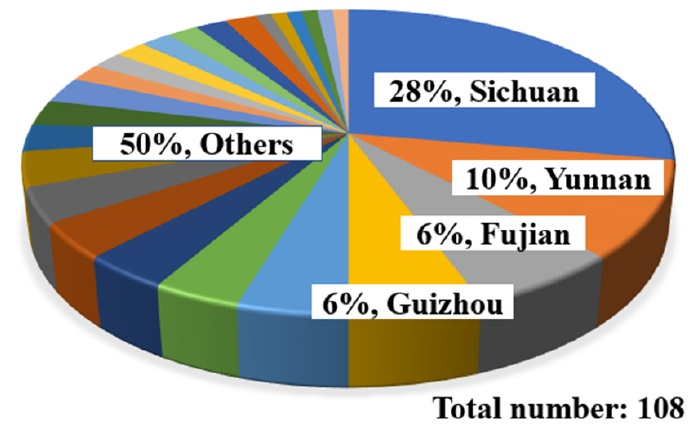
Figure 4. Distribution of underground powerhouses all over the world.